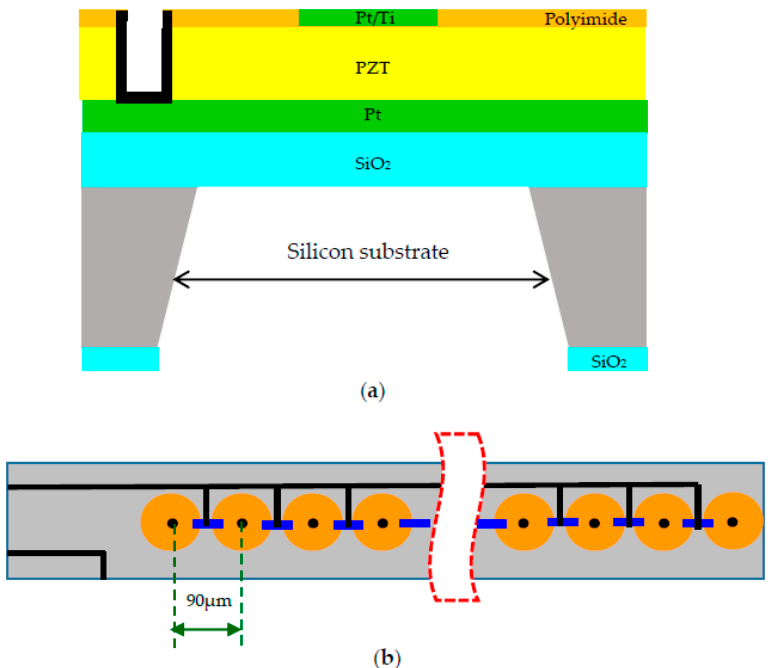
Figure 5. Fabrication process of the hydrophone linear array. ( a ) Schematic cross section illustration of a hydrophone chip. ( b ) Top view of this proposed hydrophone linear array.